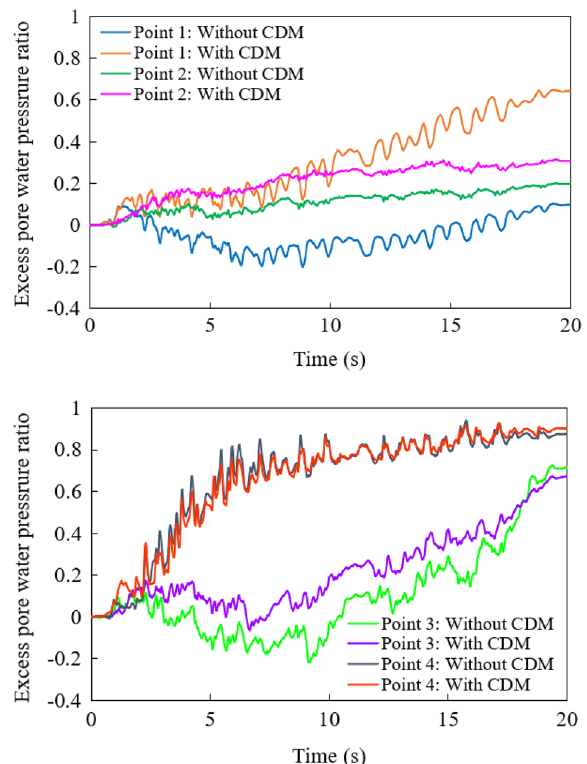
Fig. 9 Excess pore water pressure ratio at several points during the earthquake (the Coalinga motion)